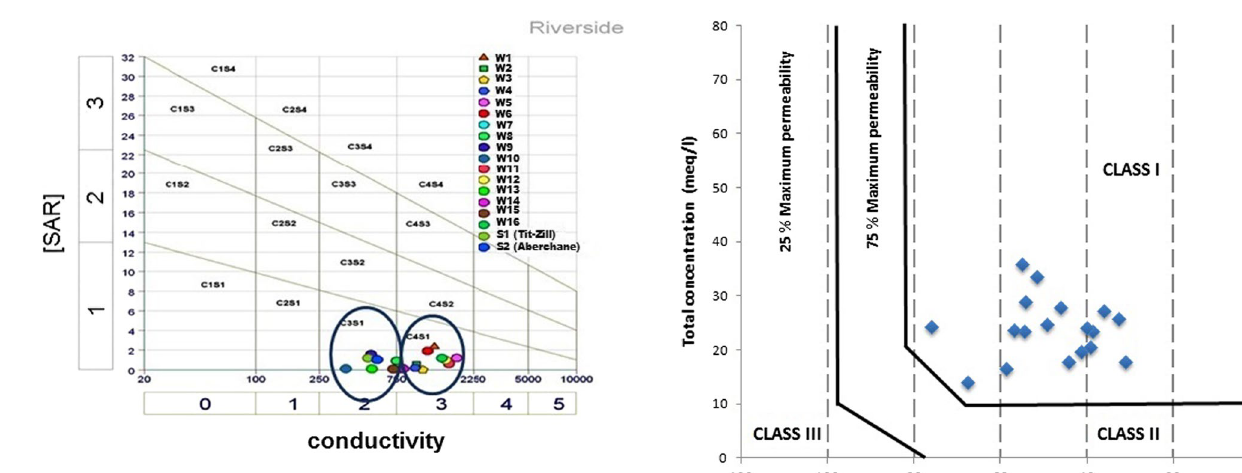
Fig. 6 Classification of irrigation waters on the Riverside diagram (Richards 1954)